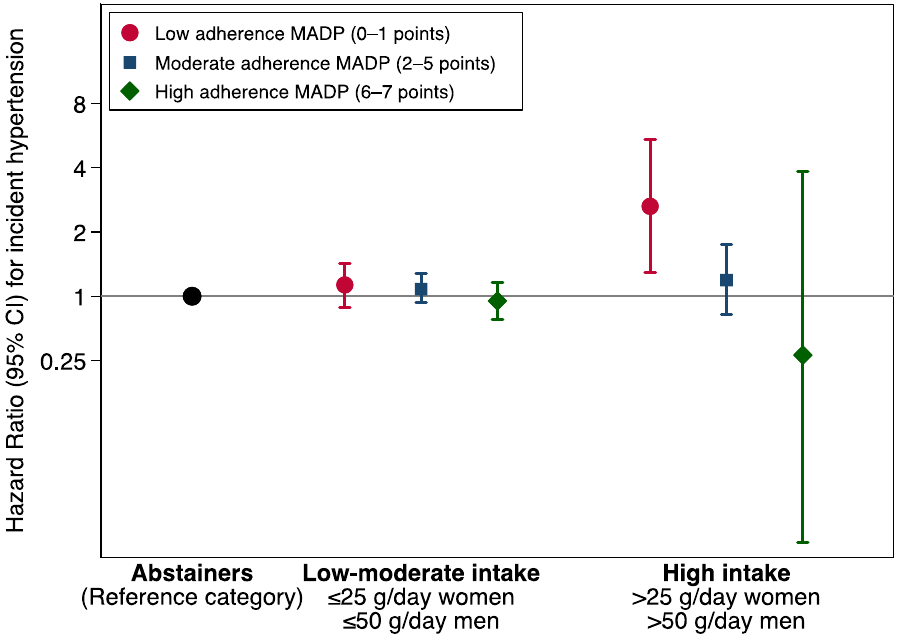
Figure 2. Hazard ratios (95% CI) for hypertension incidence according to Mediterranean alcohol drinking pattern adherence categories, stratified by alcohol intake. Alcohol intake item was removed from the calculation as the analysis was stratified for alcohol intake. The SUN Project 1999– 2018.